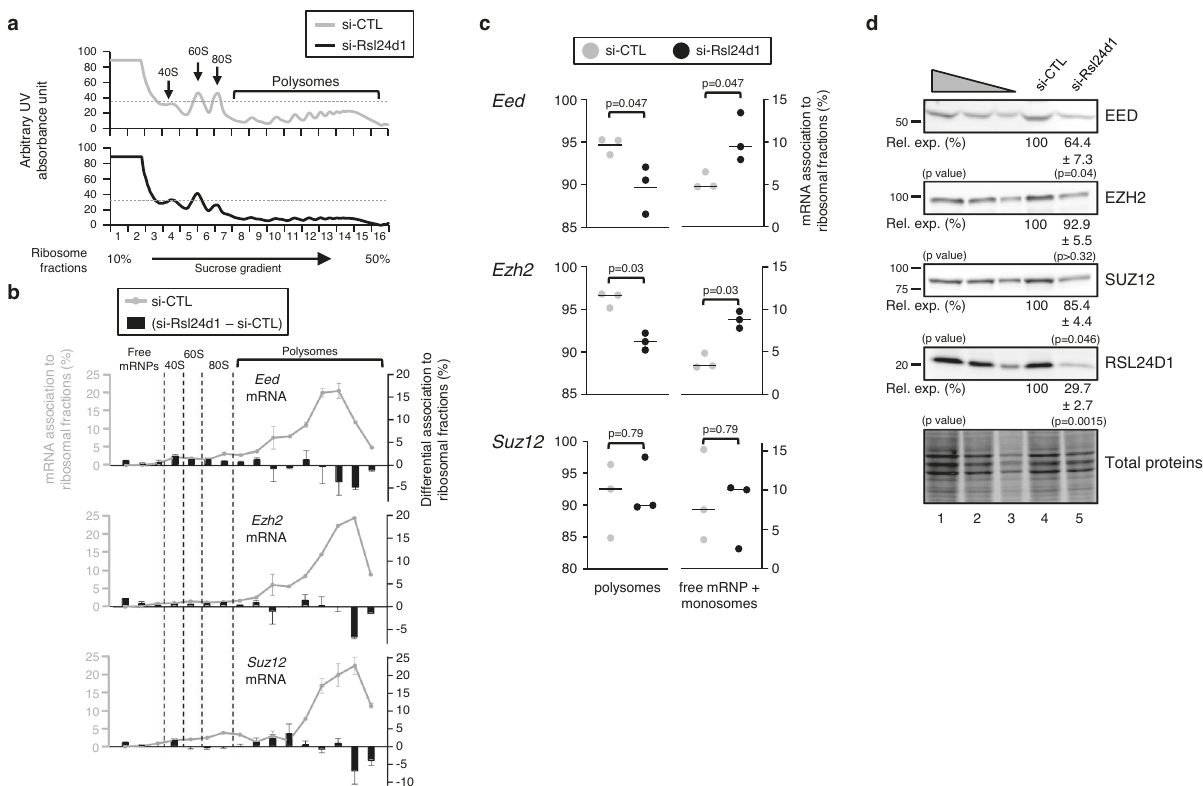
Fig. 5 | RSL24D1 depletion impairs the translation of core PRC2 factors. a Polysome pro fi ling obtained after centrifugation on sucrose gradients of cyto- plasmic extracts from naïve pluripotent CGR8 cells treated with non-targeting (si-CTL, gray) or Rsl24d1-targeting siRNAs (si-Rsl24d1, black). 40S, 60S, 80S monosomes and polysomes are detected by UV-absorbance and indicated on the absorbance curve. b Graphs representing Eed , Ezh2, and Suz12 mRNA levels mea- sured by RT-qPCR in each fraction collected from three independent polysome pro fi lingassays(graycurves,leftscales)afternormalizationwithaLuciferasespike- in mRNA and relative to the total amount of mRNAs detected in the polysome pro fi ling (sum of all fractions). The bar graph represents the differential detection of each mRNA in each fraction in CGR8 cells treated with si-Rsl24d1 and control